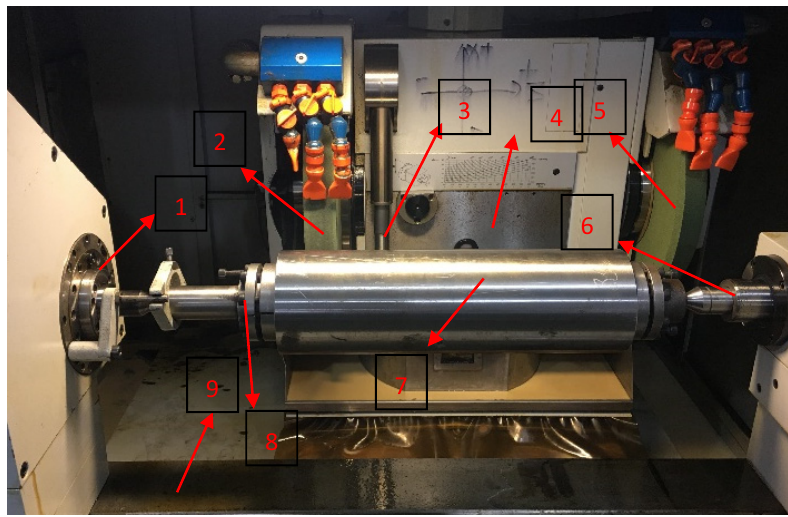
Figure 5. Actual machining site of motorized spindle. 1—workpiece C axis; 2—cylindrical grinding wheel; 3—ruby probe; 4—axis B; 5—30° end face grinding wheel; 6—tailstock; 7—motorized spindle